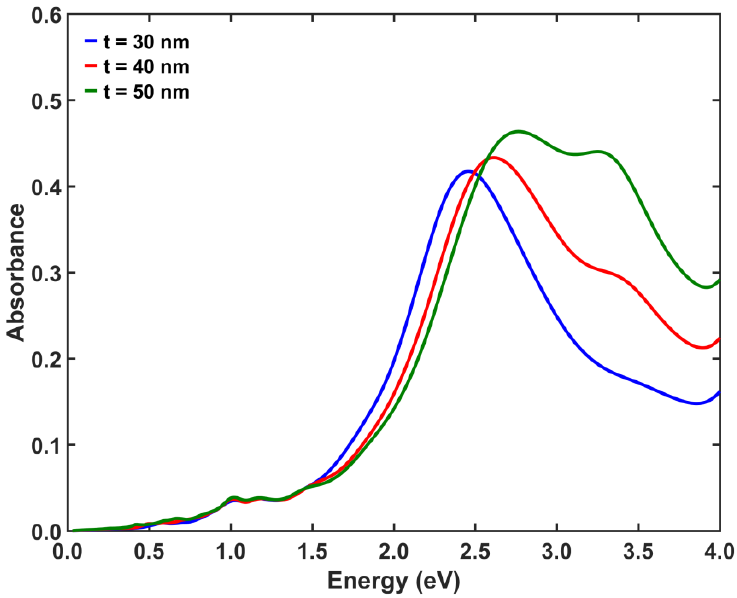
Figure 8. The absorbance spectrum of 85 at.% Α g and 15 at.%Pd, when d = 100 nm, a = 200 nm.